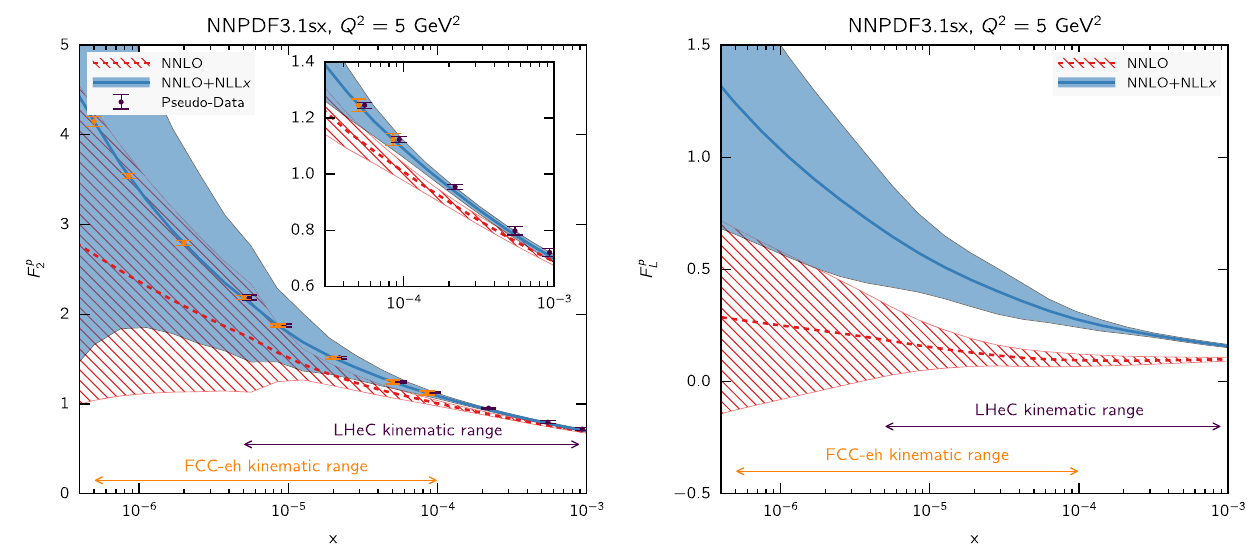
Fig. 35 Predictions for the F 2 and F L structure functions using the NNPDF3.1sx NNLO and NNLO+NLL x fits at Q 2 = 5 GeV 2 for the simulated kinematics of the LHeC and FCC-eh. In the case of F 2 , we also show the expected total experimental uncertainties based on the simulated pseudo-data, assuming the NNLO+NLL x values as central